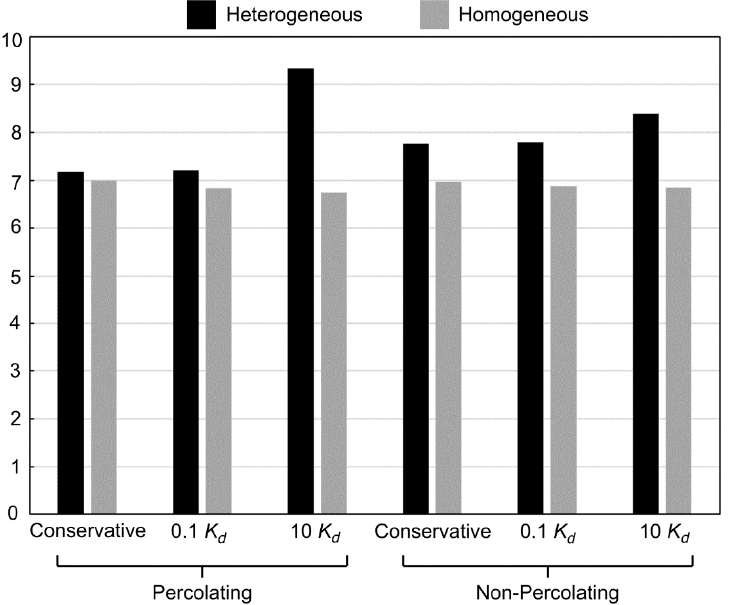
Figure 5. Percentage of solute mass in upwelling cells (or percentage of total mass returning to the river after exchange occurs). Black and gray indicate heterogeneous and homogeneous simulations, respectively. Water 2020 , 12 , x FOR PEER REVIEW